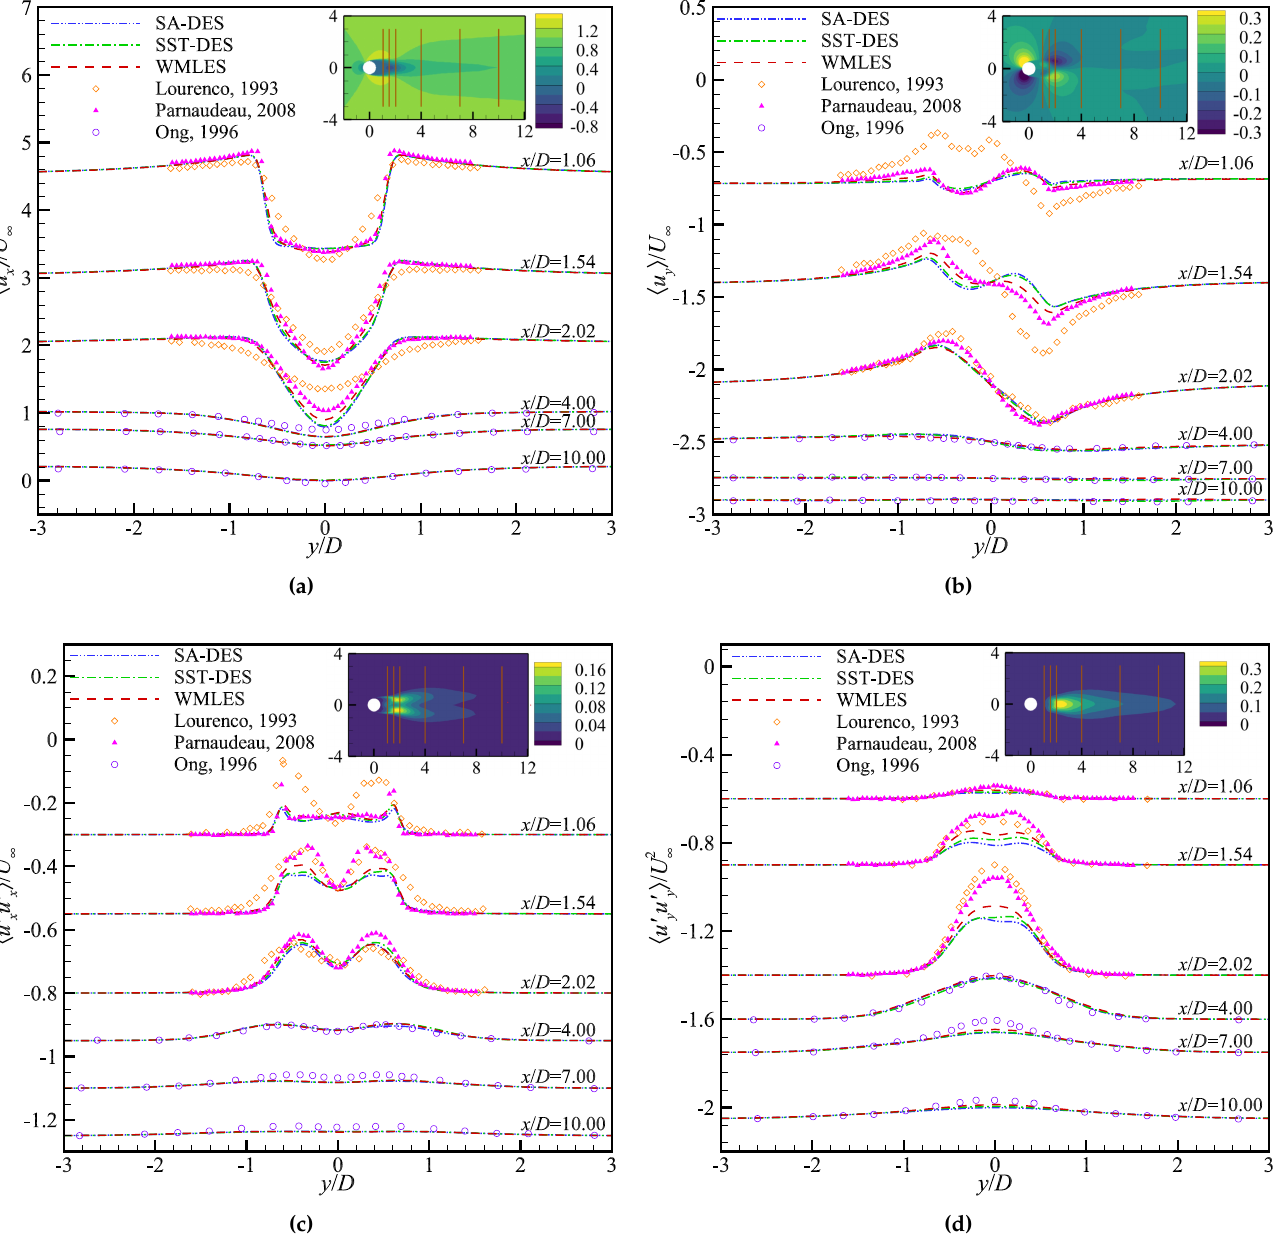
Figure 7. Mean velocity and mean resolved Reynolds stress profiles at x / c = 1.06, 1.54, 2.02, 4.00, 7.00 and 10.00 in the wake region of cylinder: ( a ) Mean streamwise velocity, ( b ) mean normal velocity, ( c ) mean resolved streamwise Reynolds stress and ( d ) mean resolved normal Reynolds stress